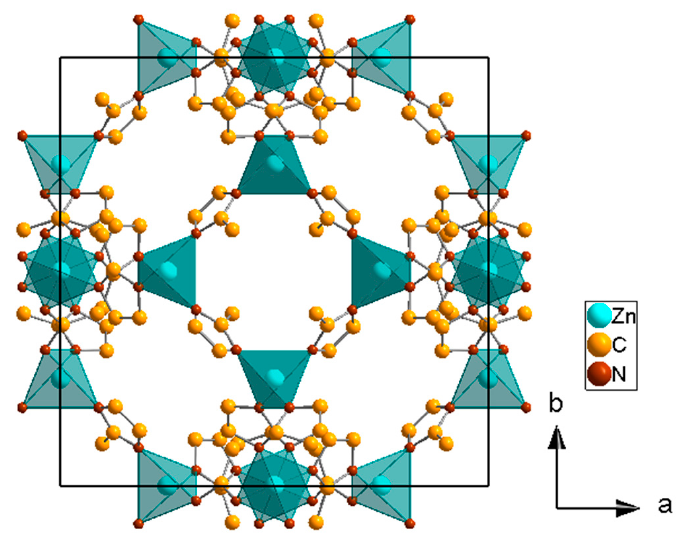
Figure 2. Crystal Structure of ZIF-8 (space group I-43 m, a = 16.8815(5) Å, V = 4811.0(4) Å, Z = 12) [27].